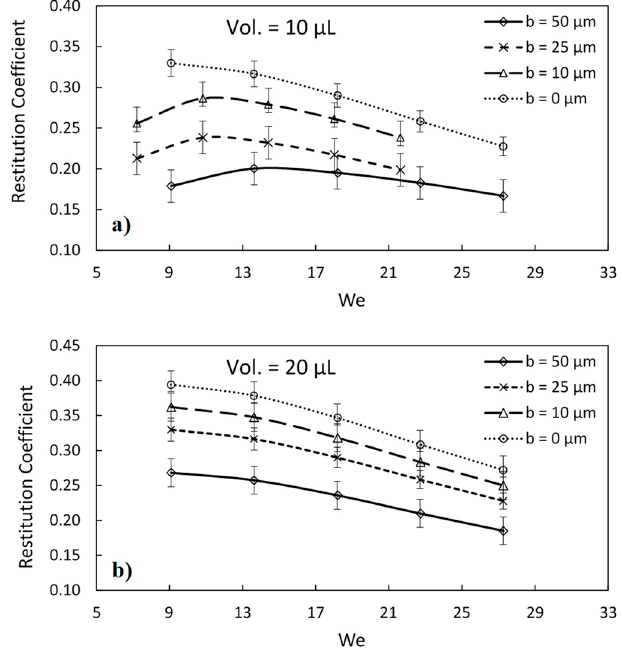
Figure 8. Restitution coefficient with Weber number for different micro-post spacings and droplet volumes: ( a ) 10 µ L and ( b ) 20 µ L. The micro-post spacing b = 0 represents the flat hydrophobized surface.